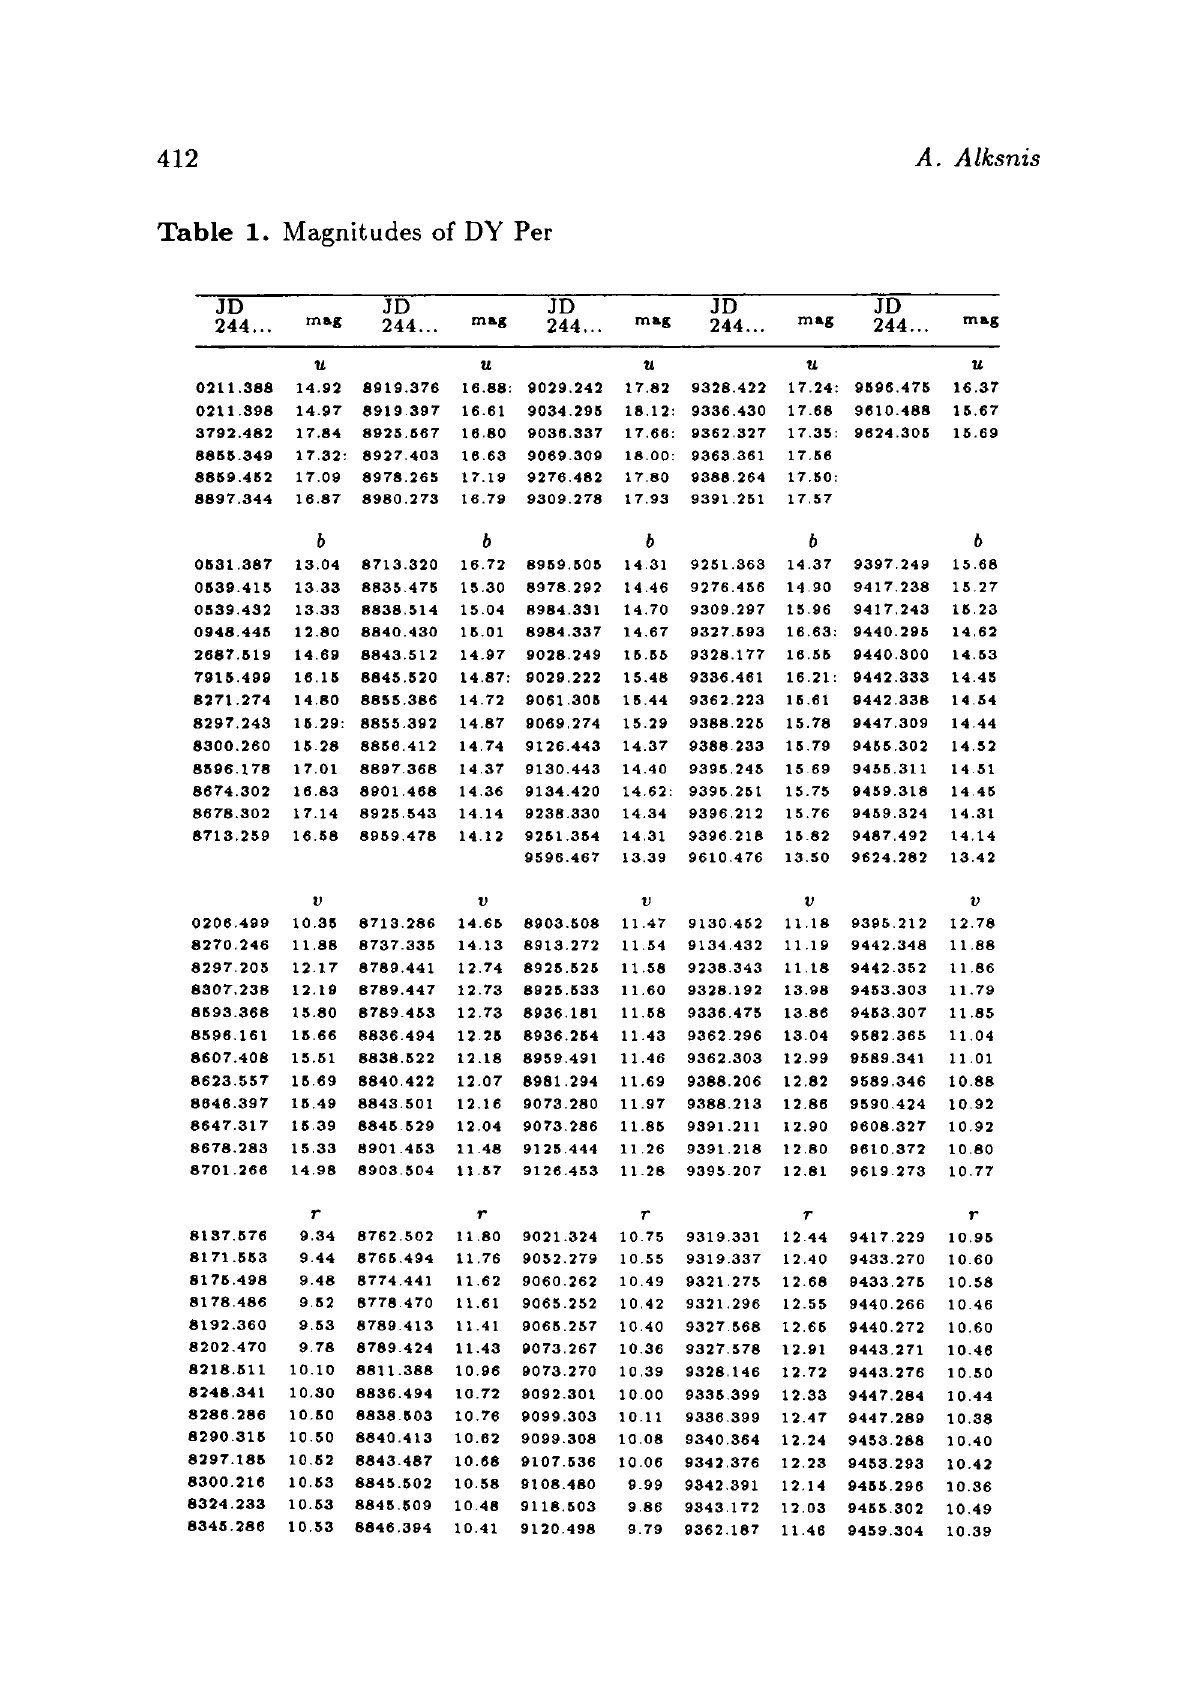
Table 1. Magnitudes of DY